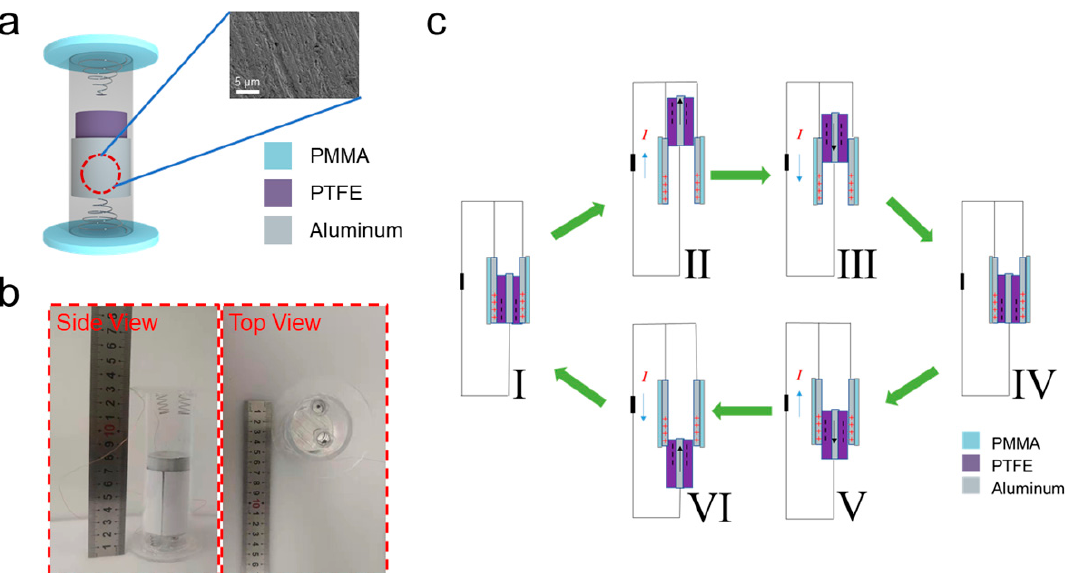
Figure 1. ( a ) Schematic Illustration of the CS-TENG device assembled using a PP outer tube attached to an AO-treated aluminum film, an aluminum inner cylinder wrapped in a PTFE film, and two springs fixed on each end of the device, which was enclosed by two PMMA plates. Inset image shows the rough surface morphology of the AO-treated aluminum film. ( b ) Digital photographs of the CS-TENG taken from the top view and the side view. ( c ) Schematic diagram showing the working principles of the developed CS-TENG, divided into six basic stages.